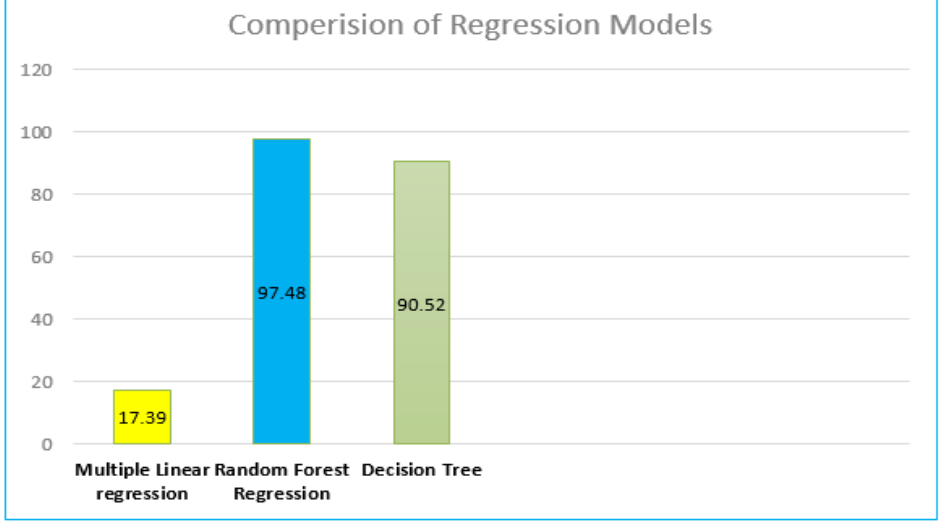
Figure 15. Comparison of Regression Models.